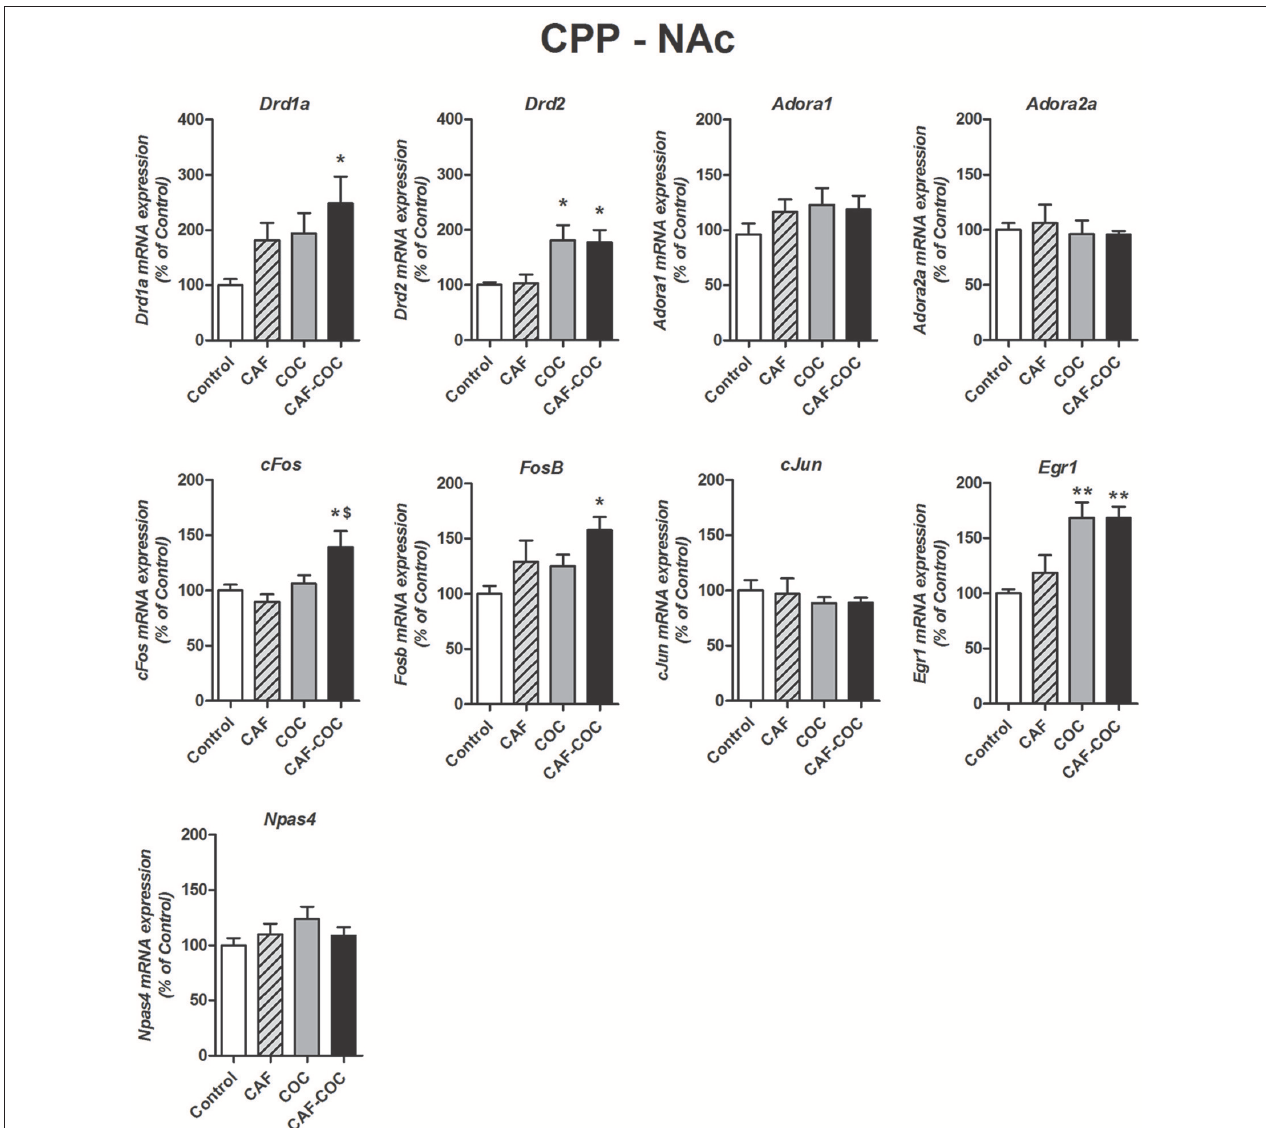
FIGURE 4 | Gene expression changes induced in the NAc by caffeine and cocaine-associated memory retrieval in the CPP. Dopamine receptor subunits Drd1a and Drd2 ; adenosine receptor subunits Adora1 and Adora2a ; IEGs FosB , cFos , cJun , Egr1 , Npas4 . Values indicate mean ± SEM. One-way ANOVA–Tukey. Kruskal–Wallis One–way ANOVA on ranks was used for Drd2 data. * p < 0.05, ** p < 0.01 different from Control. $ p < 0.05, different from COC.